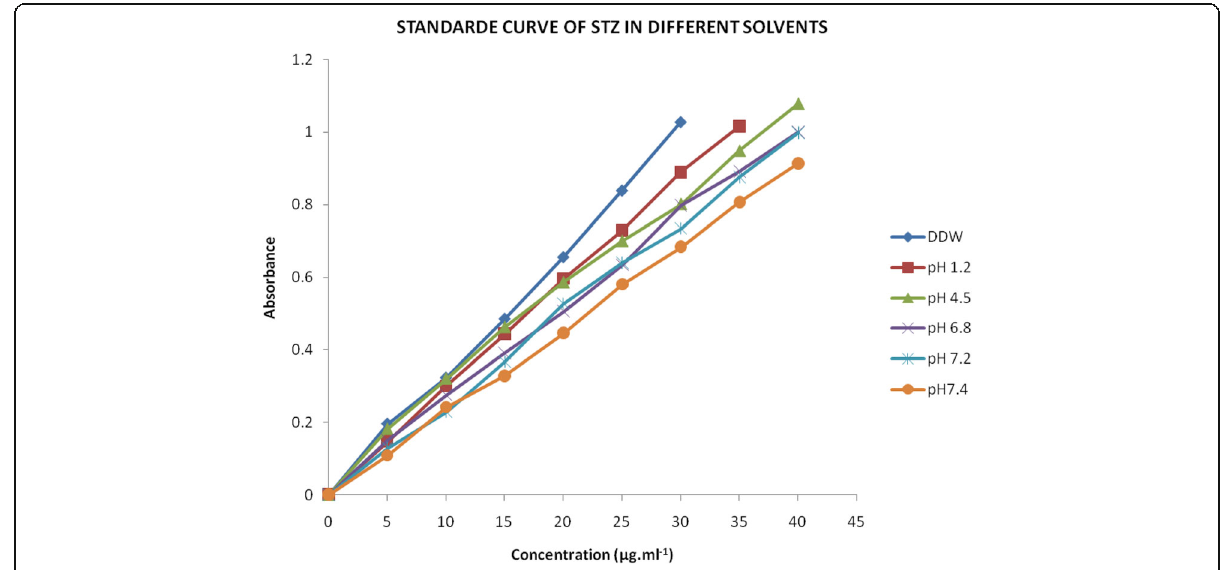
Fig. 1 Graphical representation of linear curves of